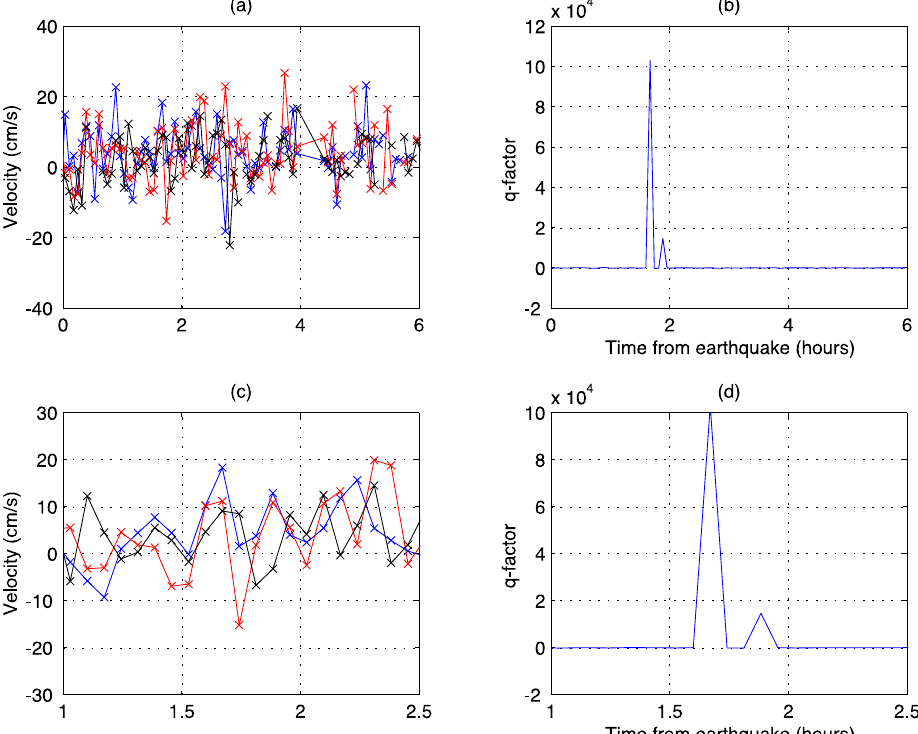
Figure 5. HUTB radar observations 11 April 2012. ( a ) Velocity vs. time from 8:38 UTC. Blue: 6–12 km; Red: 12–18 km; Black: 18–24 km. ( b ) The q-factor corresponding to (a) with the tsunami arrival indicated by the first peak, followed closely by a smaller secondary peak. ( c ) Velocity vs. time for 1.5 hours surrounding the arrival of the tsunami: Blue: 6–12 km; Red: 12–18 km; Black: 18–24 km, showing the typical tsunami velocity arrival signature. ( d ) The q-factor corresponding to